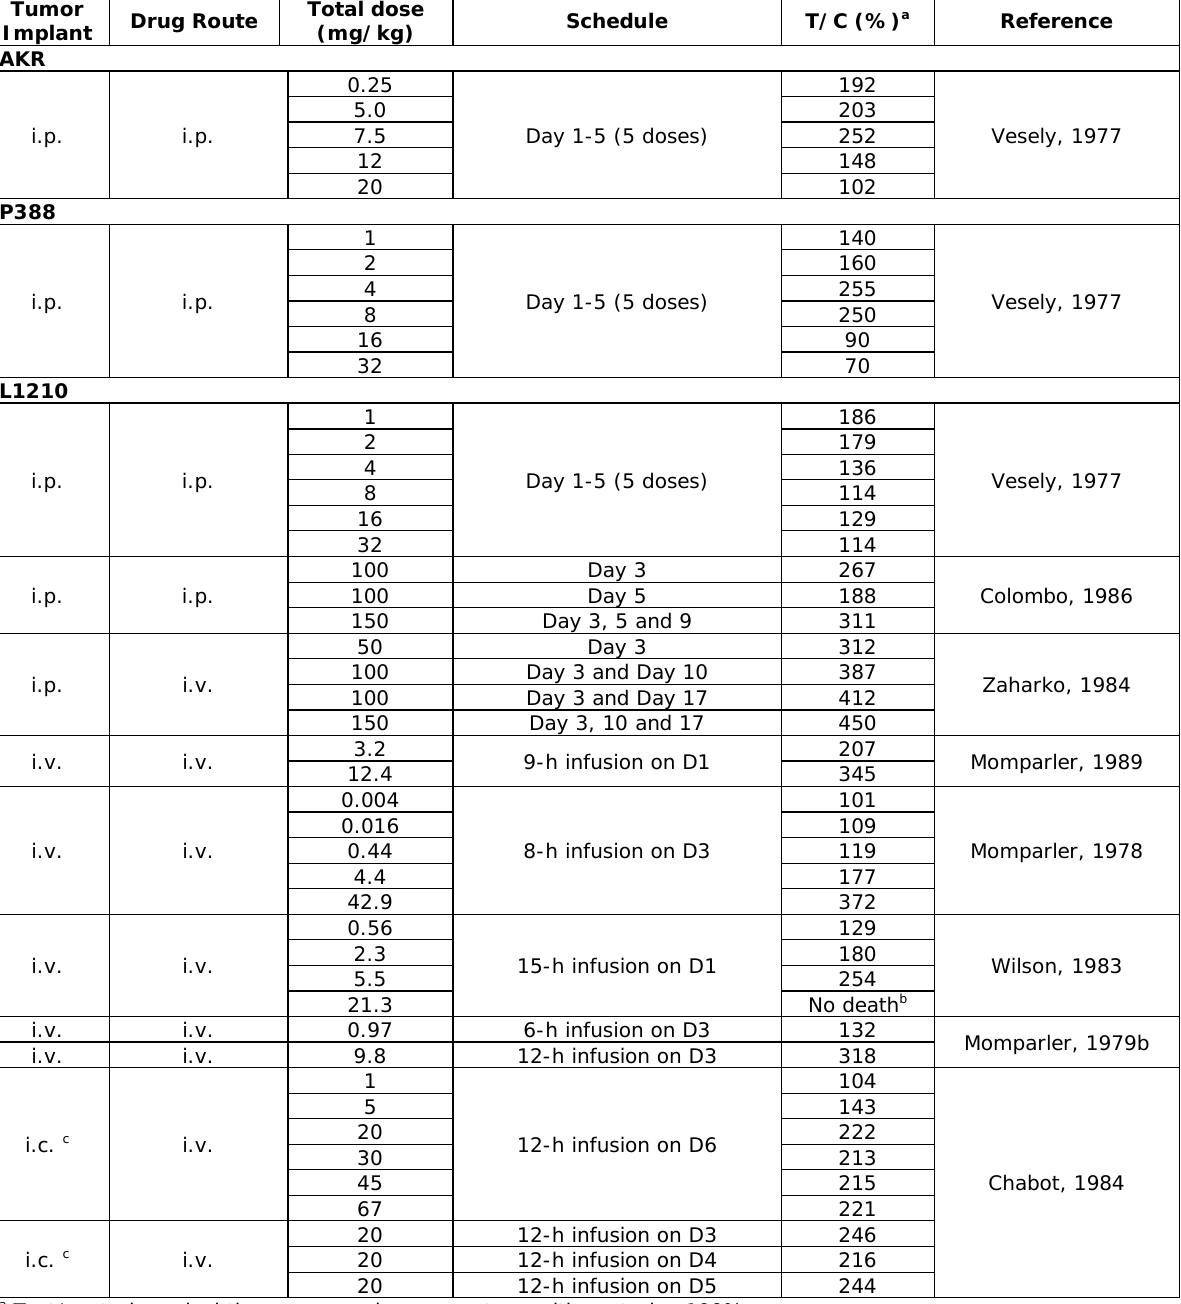
Schedule T/C (%) a Reference